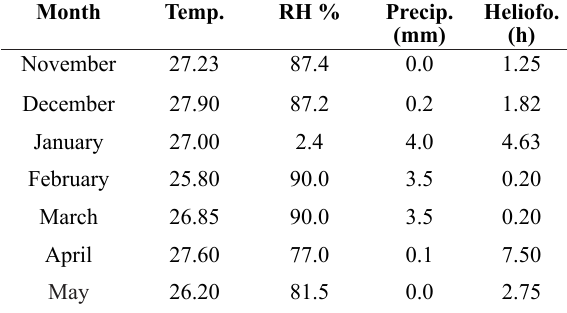
Table 3. Meteorological data on temperature, relative hu- midity, heliophane and precipitation during the evaluation months.